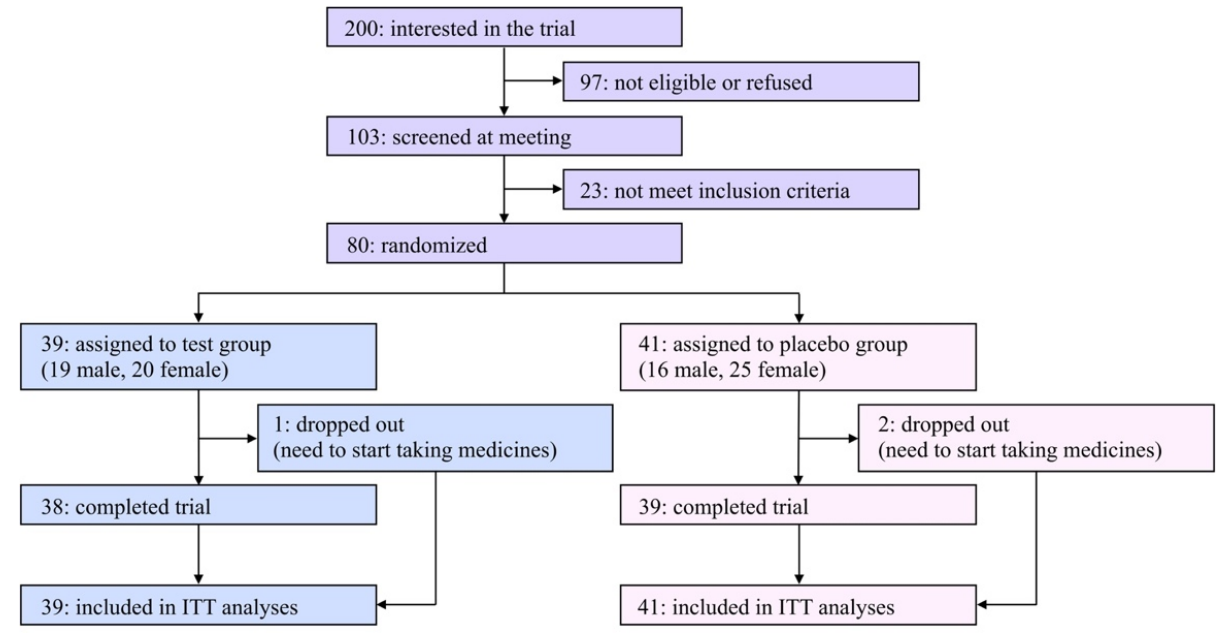
Figure 1. Flow diagram of participants in the present study. Table 1. The characteristics of the eligible participants at baseline.